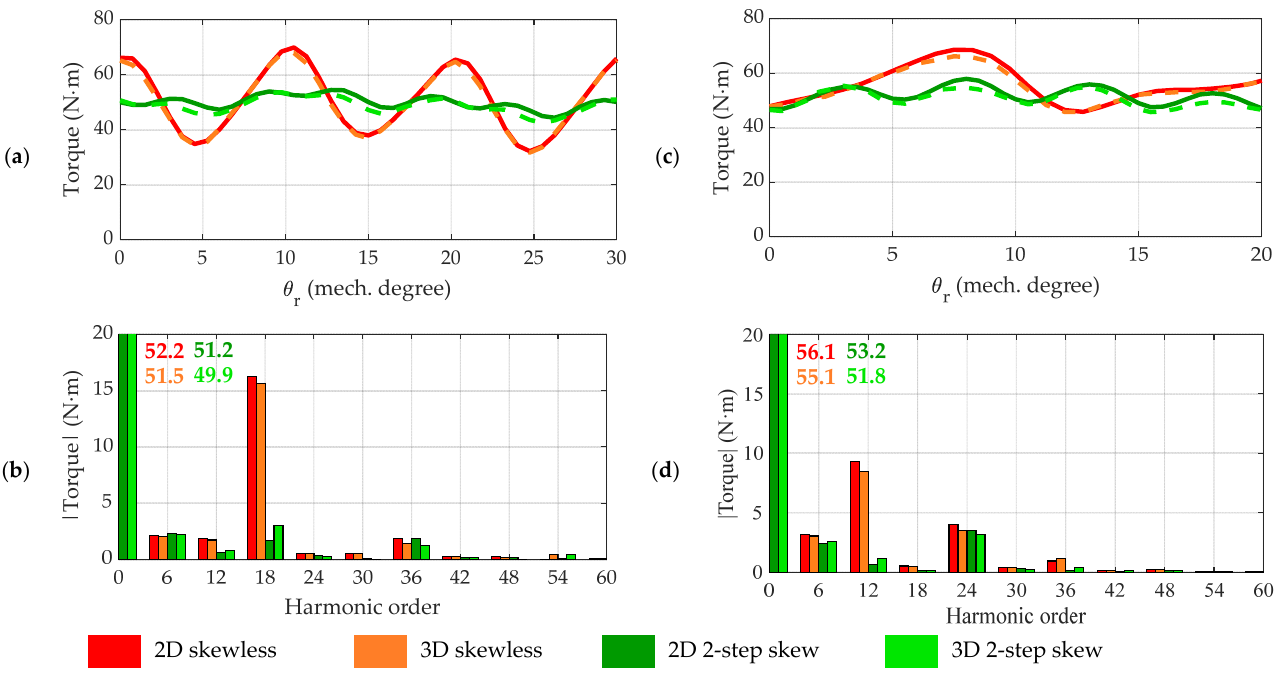
Figure 6. Comparison of electromagnetic torque waveform and harmonic content of a skewless machine vs. two-step skewed machine: ( a ) torque waveform of four-pole machine with two barriers per pole; ( b ) torque spatial harmonic content of four-pole machine with two barriers per pole; ( c ) torque waveform of six-pole machine with two barriers per pole; ( d ) torque spatial harmonic content of six-pole machine with two barriers per pole. The 2D and 3D simulation results are compared.